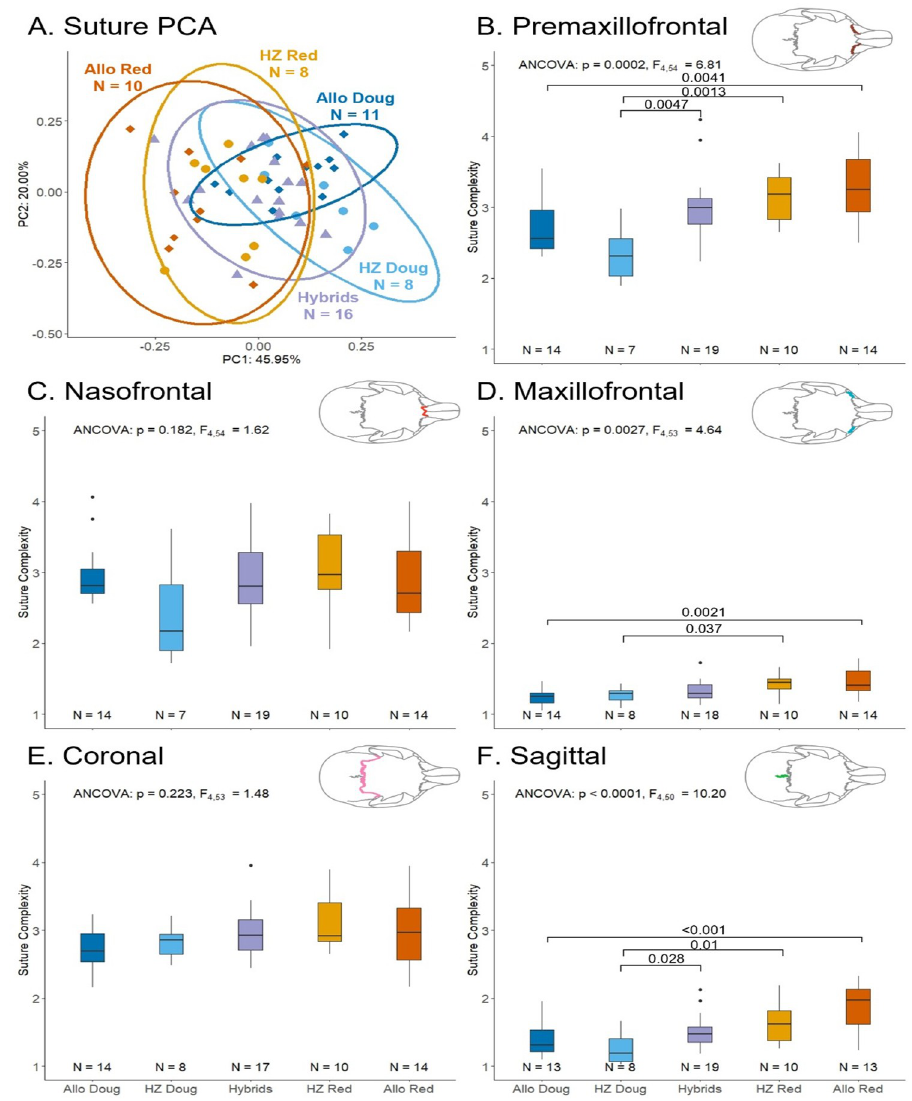
2. (A) Principal component analysis for all five sutures. (B) ANCOVA for the premaxillofrontal suture. (C) ANCOVA for the nasofrontal suture. (D) ANCOVA for the maxillofrontal suture. (E) ANCOVA for the coronal suture. (F) ANCOVA for the sagittal